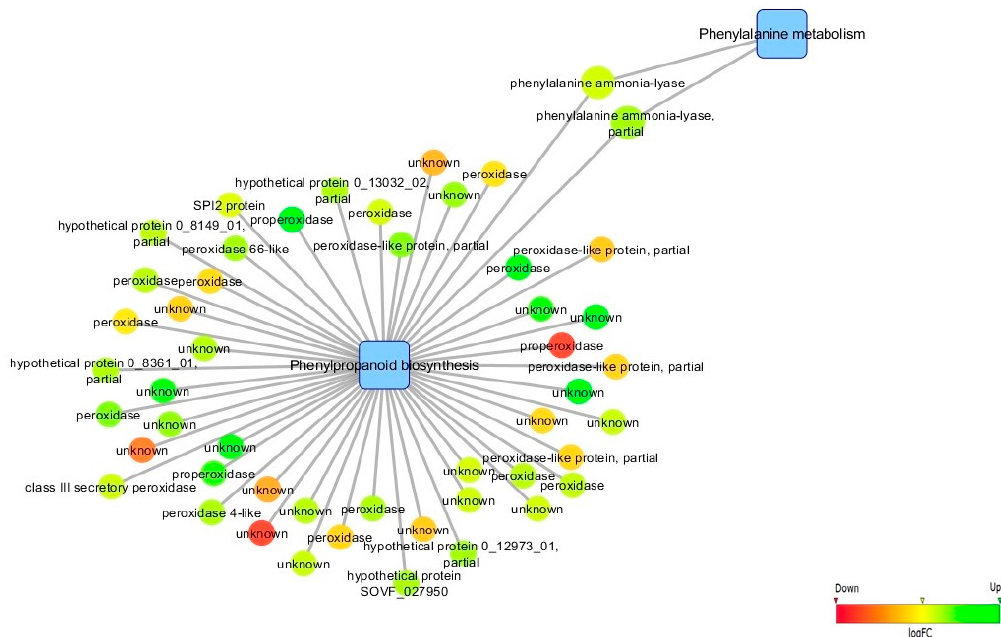
Figure 3. Phenylpropanoid biosynthesis pathway with interactions related to DE genes in the comparison Pp01–Pp02. The blue square nodes represent the pathways. The rest of the nodes represent all DE genes associated to the pathways. Note that due to the complexity of representing the expression values of those genes, the RGB color scale goes from the most down regulated in red to the most up regulated in green.